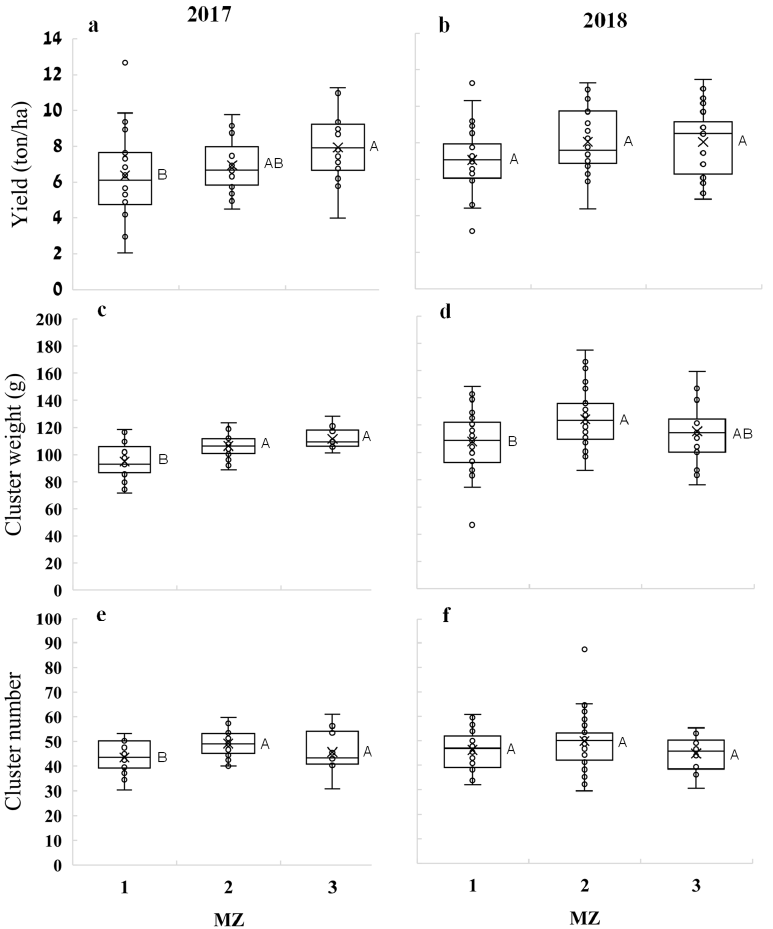
Figure 12. Boxplot of yield and fruit quality variables in the management zones (MZs) for 2017 ( a , c , e ) and 2018 ( b , d , f ): handpicked yield for 2017 ( a ) and 2018 ( b ); vine average cluster weight in 2017 ( c ) and 2018 ( d ) and vine average cluster number in 2017 ( e ) and 2018 ( f ). Data were collected from 240 measurement vines within the vineyard; MZ1—88 vines, MZ2—112 vines and MZ3—40 vines. Significant differences among MZs were calculated using ANOVA ( α = 0.05). Different let- ters represent significant differences between MZs.